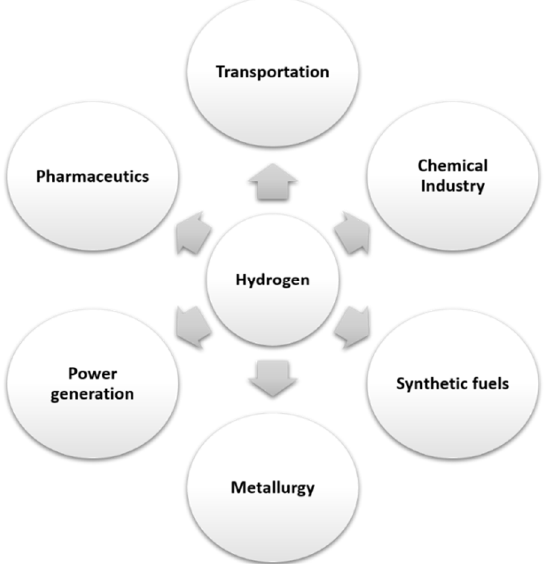
Figure 1. Areas of applicability of hydrogen.